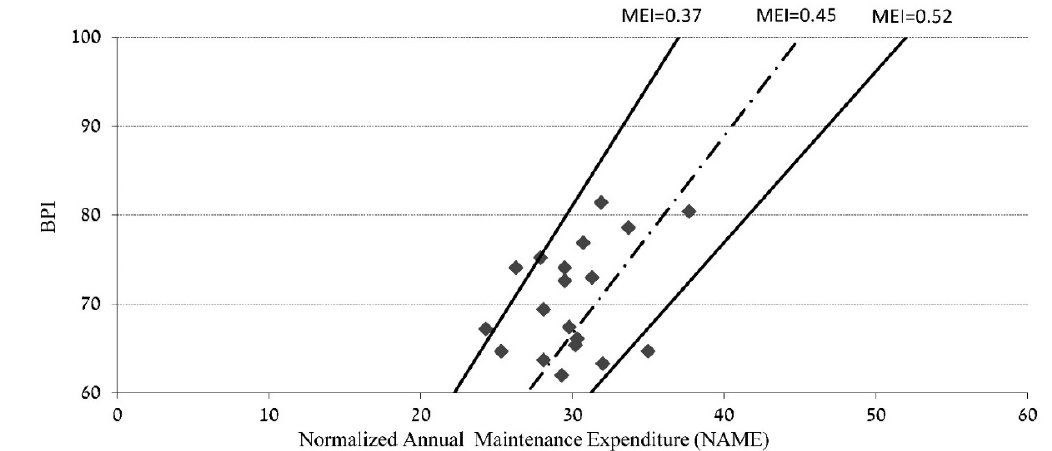
Fig. 5. Building Performance Indicator ( BPI ) vs. Normalized Annual Maintenance